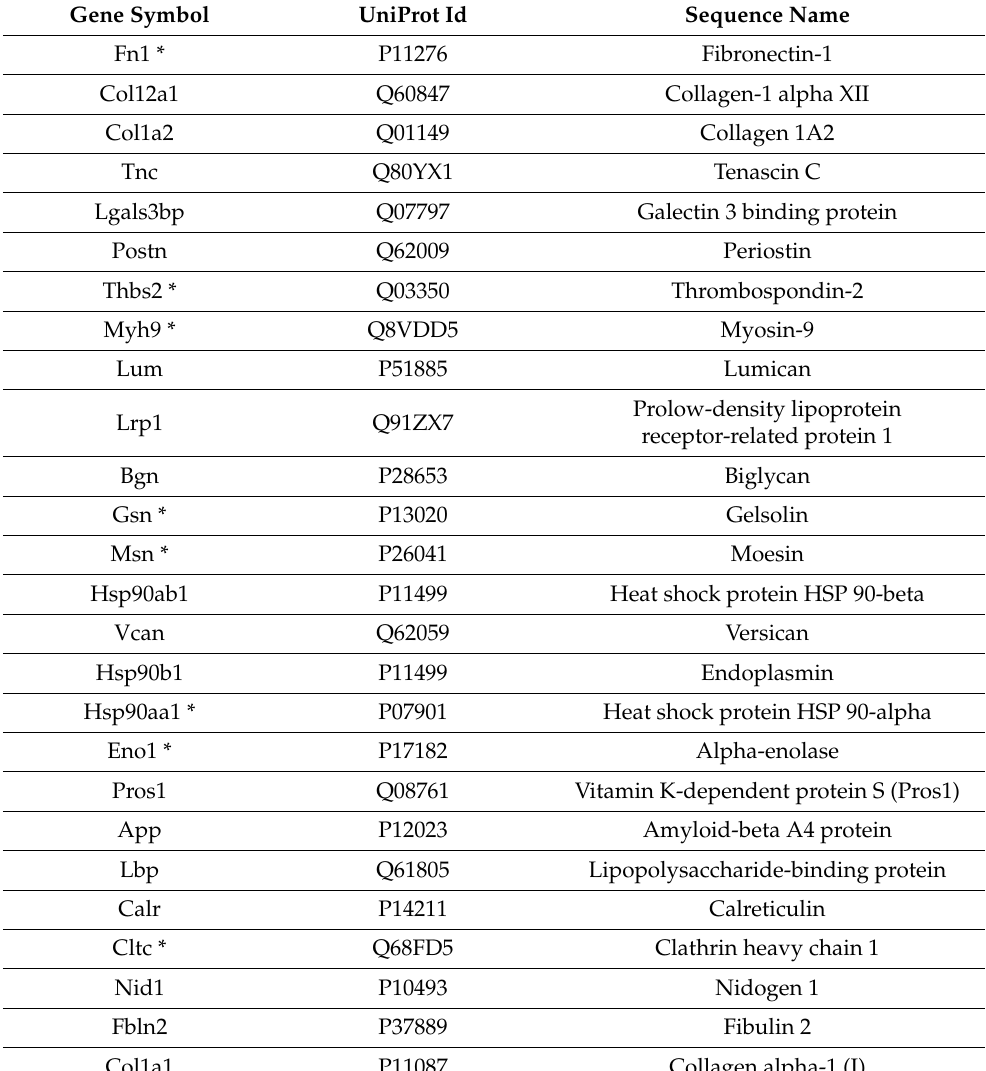
Table 1. Proteins detected in lyophilized EVs previously detected in exosomes (ExoCarta) and in fresh EVs from ADSCs [15,16].